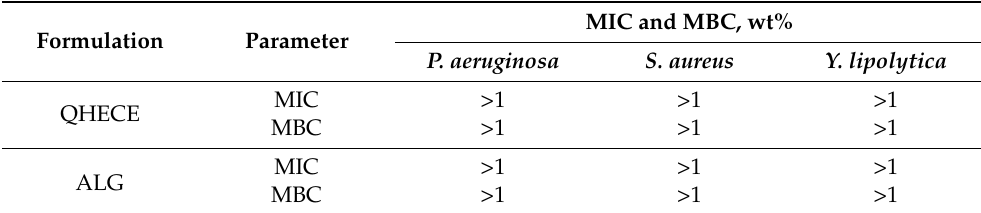
Table 2. Antimicrobial activity of polymer formulations in solution.